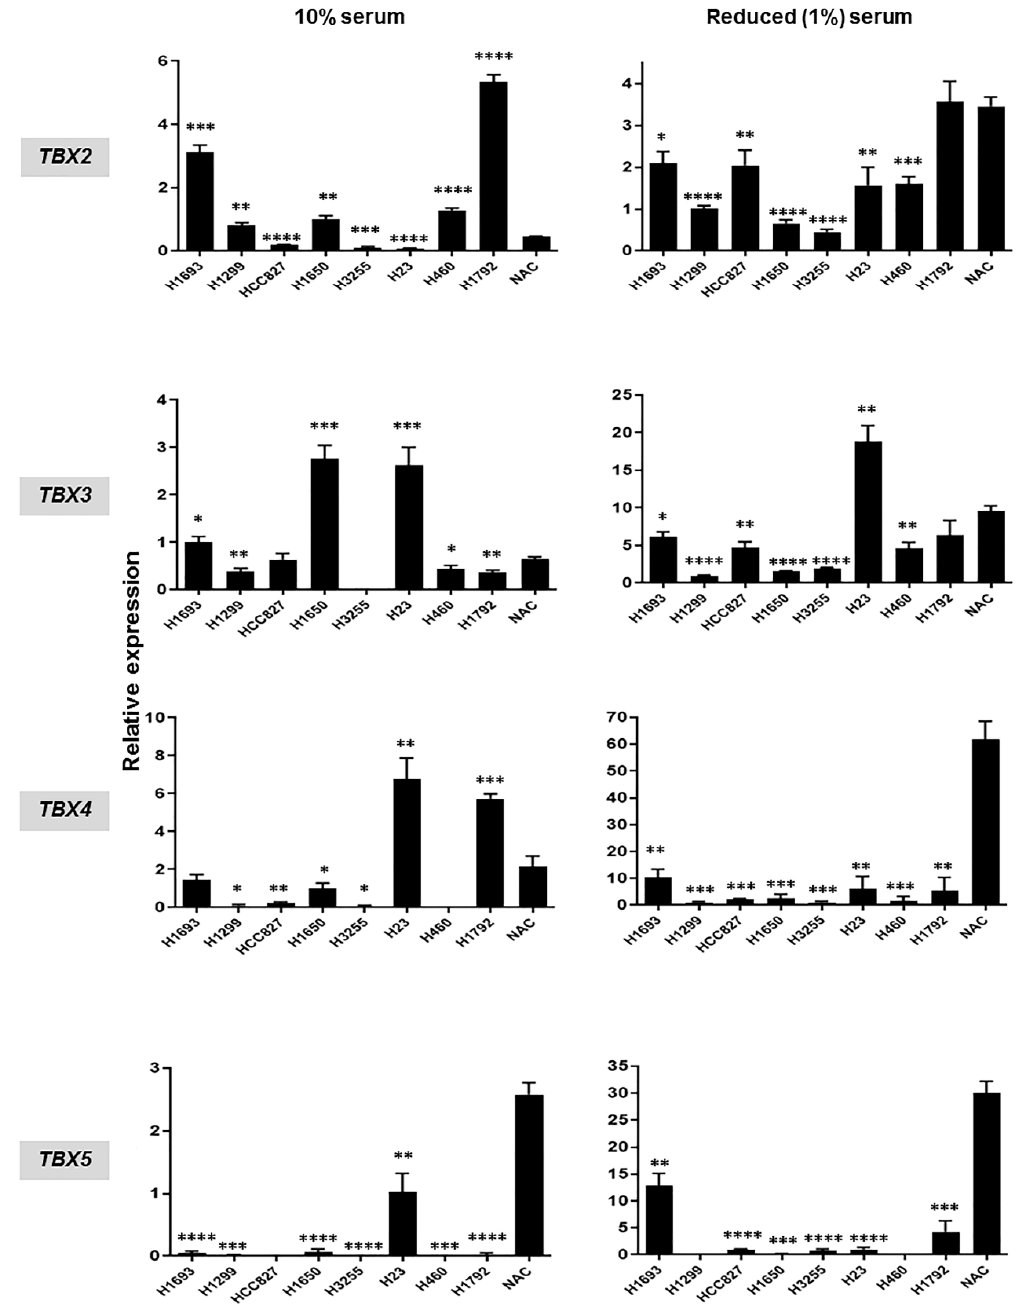
Figure 3. Suppressed expression of TBX2 subfamily in non-small cell lung cancer (NSCLC) cell lines relative to normal pulmonary alveolar epithelial cells. Messenger RNA expression levels of all four members of TBX2 subfamily in NSCLC cell lines compared to normal pulmonary alveolar epithelial cells (NAC) were analyzed in triplicates by qRT-PCR. Analysis was performed on NSCLC cell lines grown in serum-containing medium (10% FBS; left panels) as well as on cells maintained in media with reduced serum (1% FBS; right panels). Relative expression data in each of the NSCLC cell lines and for each of the TBX genes were computed using the 2 − ∆∆ C t calculation method by normalization to glyceraldehyde 3-phosphate dehydrogenase (GAPDH) and are presented as mean ± SEM (* p < 0.05; ** p < 0.01; *** p < 0.001; **** p < 0.0001) compared to normal alveolar epithelial cells (NAC). We then probed the extent of epigenetic suppression by hypermethylation of the TBX genes in the NSCLC cell lines. To achieve this, we performed methylation-specific polymerase chain reaction